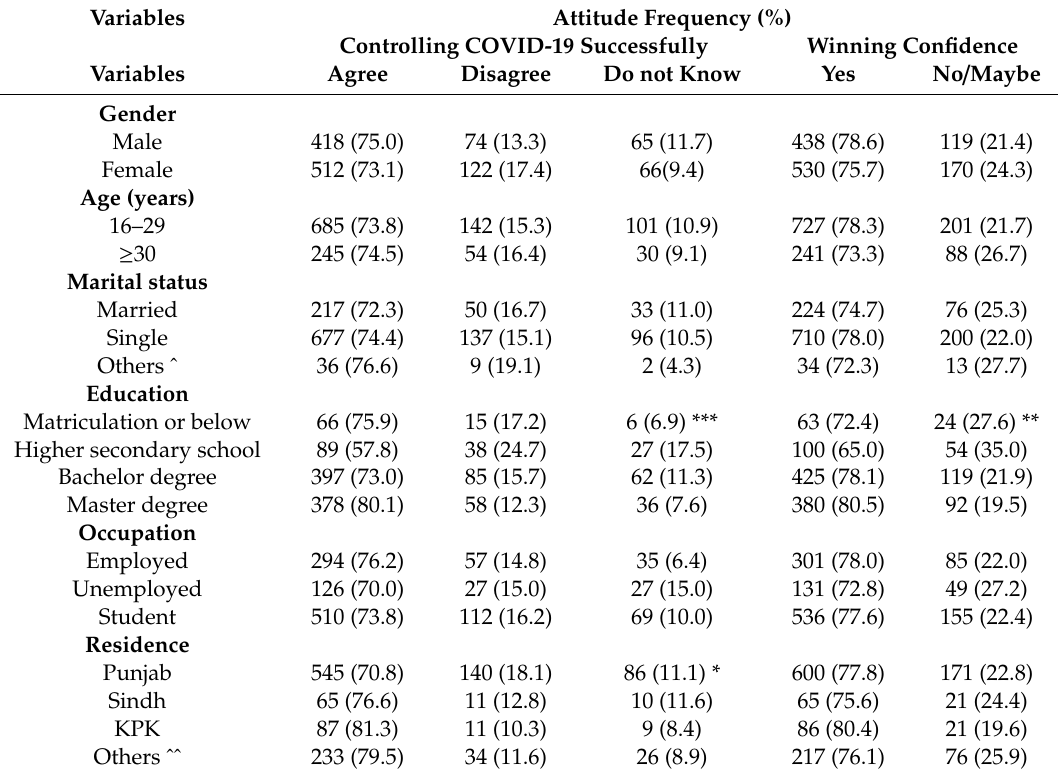
Table 4. Attitude of the participants about COVID-19 by